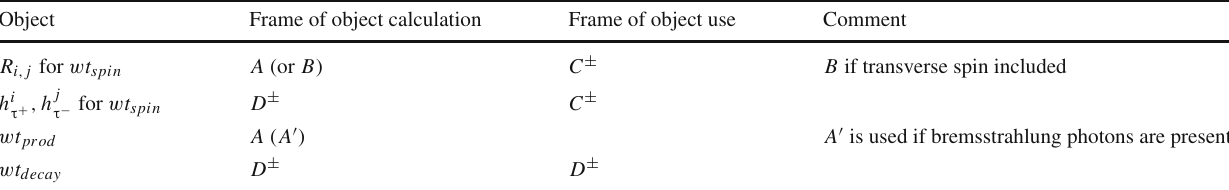
Table 1 Frames used for the calculation of components used in weights calculation, Eq. (10). Specified are also frames to which these components need to be transformed Object Frame of object calculation Frame of object use